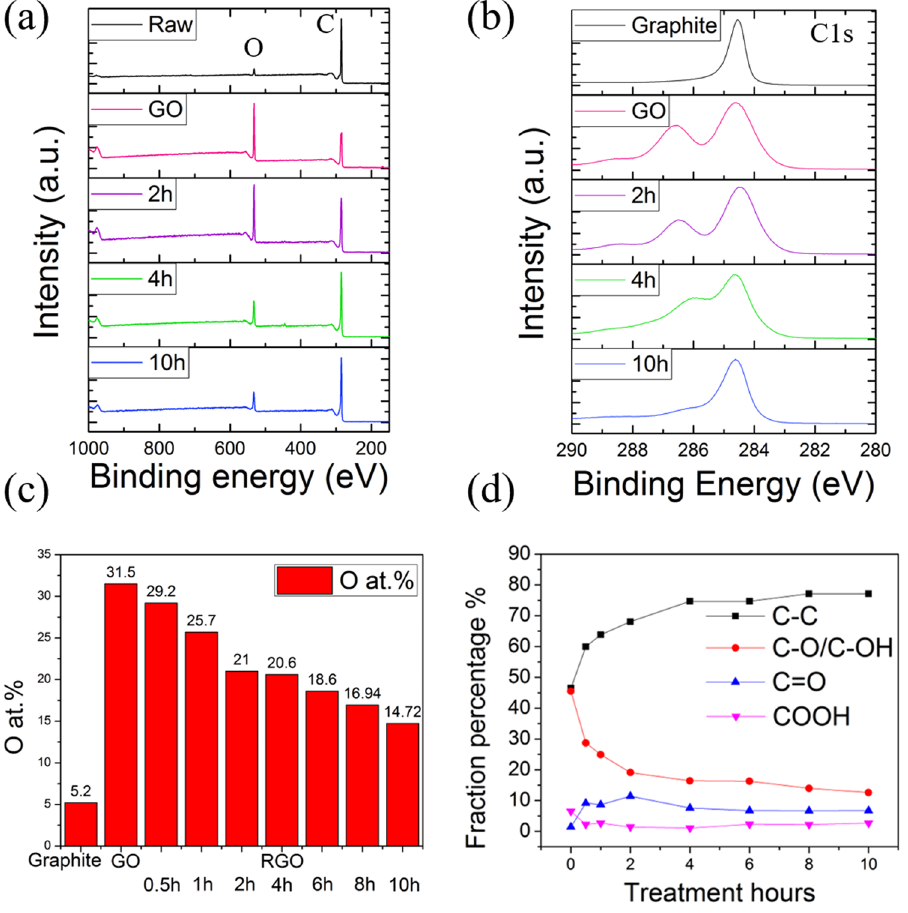
Figure 4. ( a ) XPS full spectra of raw graphite, GO, rGO 2 h, 4 h, and 10 h samples and ( b ) the corresponding high resolution C1s spectra. ( c ) Oxygen content as a function of reduction time. ( d ) Change in fraction percentage of the individual oxygen function group with reduction